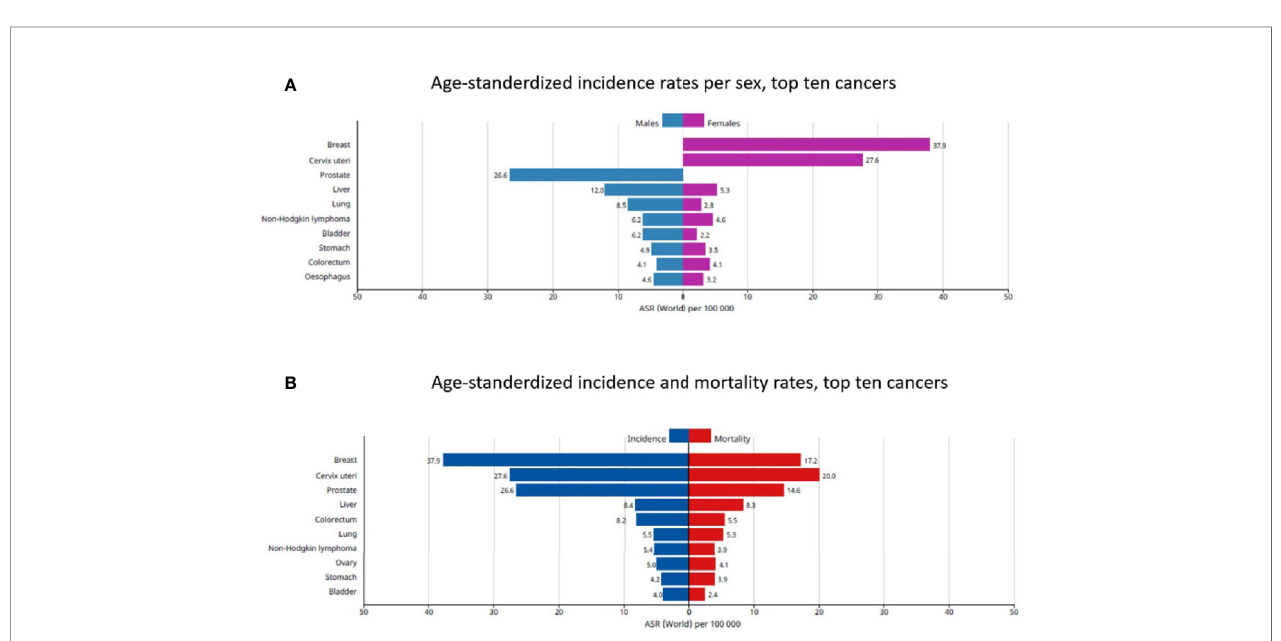
FIGURE 2 | The top 10 cancers in African patients. (A) Age-standardized incidence rates per sex, (B) Age-standardized incidence and mortality rates. Reproduced from "The Global Cancer Observatory, Africa Globocan 2018"